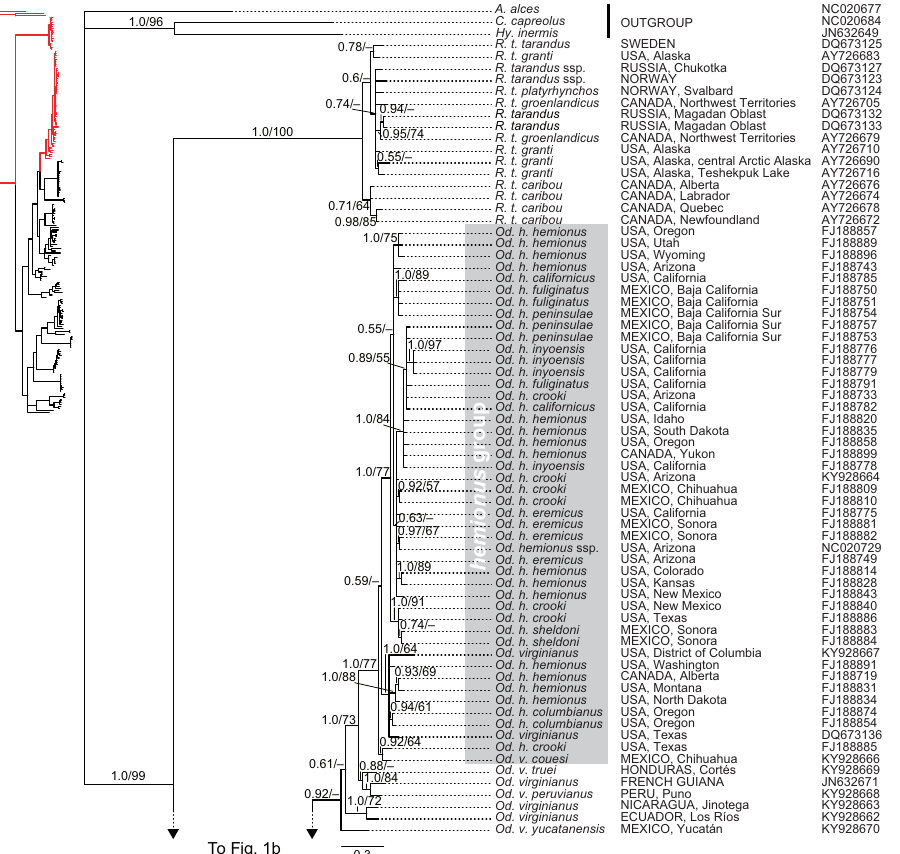
Figure 1a. Phylogenetic tree of cytochrome- b sequences of Odocoileini. This is a strict consensus to- pology resulting from the Bayesian inference analysis. Nodal support is indicated at each node, except where the relationship received negligible support. Posterior probabilities (from the Bayesian inference analysis) and bootstrap values (from the maximum-likelihood analysis) are indicated before and after the slashes (“/”) at branches of interest (i.e., nodal support for fairly shallow relationships within intraspecific haplogroups are omitted). The scale represents substitutions per site. For each terminal, country of origin and next-largest administrative unit (state, department, province, etc.) are provided (when reported by the team that generated them; see detailed voucher and locality information in supplementary file 1 for sequences that we generated). GenBank accession numbers are indicated for each